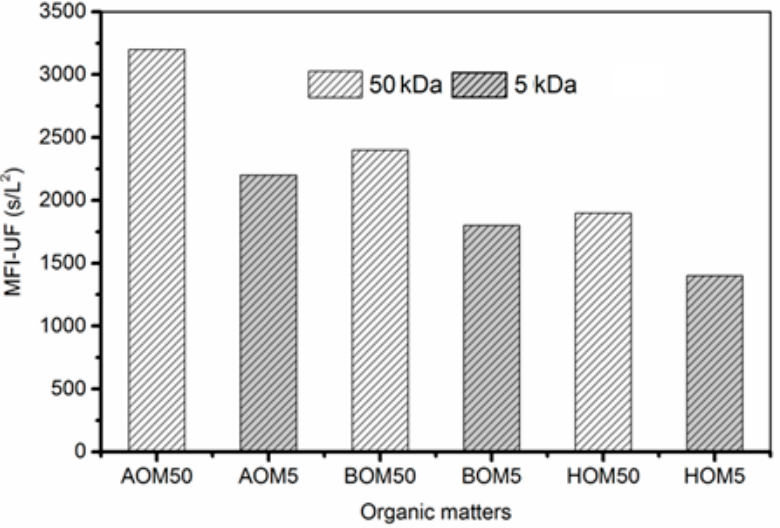
Figure 3. MFI-UF for 50 kDa and 5 kDa ceramic membranes. The MFI-UF were calculated twice for each experiment, and the deviation between two times calculations were within 5%. As shown in (Figure 3), the fouling potential was higher with the 50 kDa membrane compared to the 5 kDa one. The AOM represented the highest MFI-UF value (3200 s/L 2 ) whereas HOM gave the lowest value (2000 s/L 2 ). This observation suggests that the pore blockage mechanism is more dominant for the 50 kDa UF membranes and cake layer of the 5 kDa membrane is most probably dominating the fouling mechanism. In fact, these results are consistent with other studies (Li et al., 2011) [29]. The possibility of the three organic particles to be trapped into the larger membrane pores was higher during UF fil- tration using 50 kDa membranes, which explains the higher values of MFI-UF. AOM shows the highest MFI-UF values among the three organics and during all filtration cycles for both membranes. The AOM fouling layer is well known for having high fouling po- tential due to its compressibility and compactness, which increase the TMP and eventu- ally the MFI-UF values [28]. As shown in Figure 4, AOM and BOM showed the highest TEP concentrations in ce- ramic membrane filtration experiments for both 5 and 50 kDa membranes, which are in agreement with literature as AOM and BOM contain more polysaccharides and eventually more TEP. However, TEP on AOM was higher than BOM because of higher biopolymer fraction in AOM compared to BOM. Regarding TEP removal, this study clearly revealed that UF 5 kDa membranes can remove more TEP/organics (66–80%) compared to the 50 kDa membrane (53–57%) due to their lower MWCO (Figure 4). The results from the ceramic UF membranes were better than those reported before with existing pretreatment DMF and previous reported polymeric UF, which were about 10% and 40%, respectively [3,5].